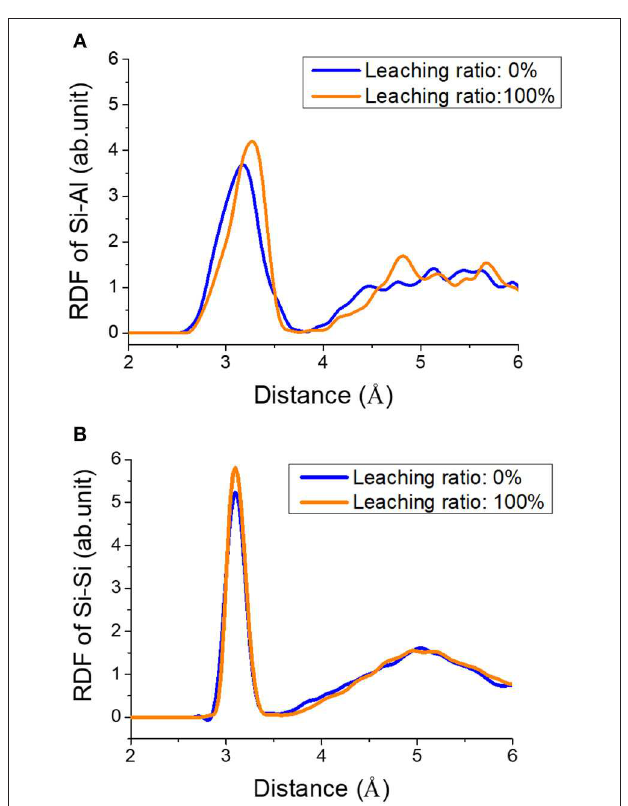
FIGURE 3 | Radial distribution function of (A) Si-Al and (B)